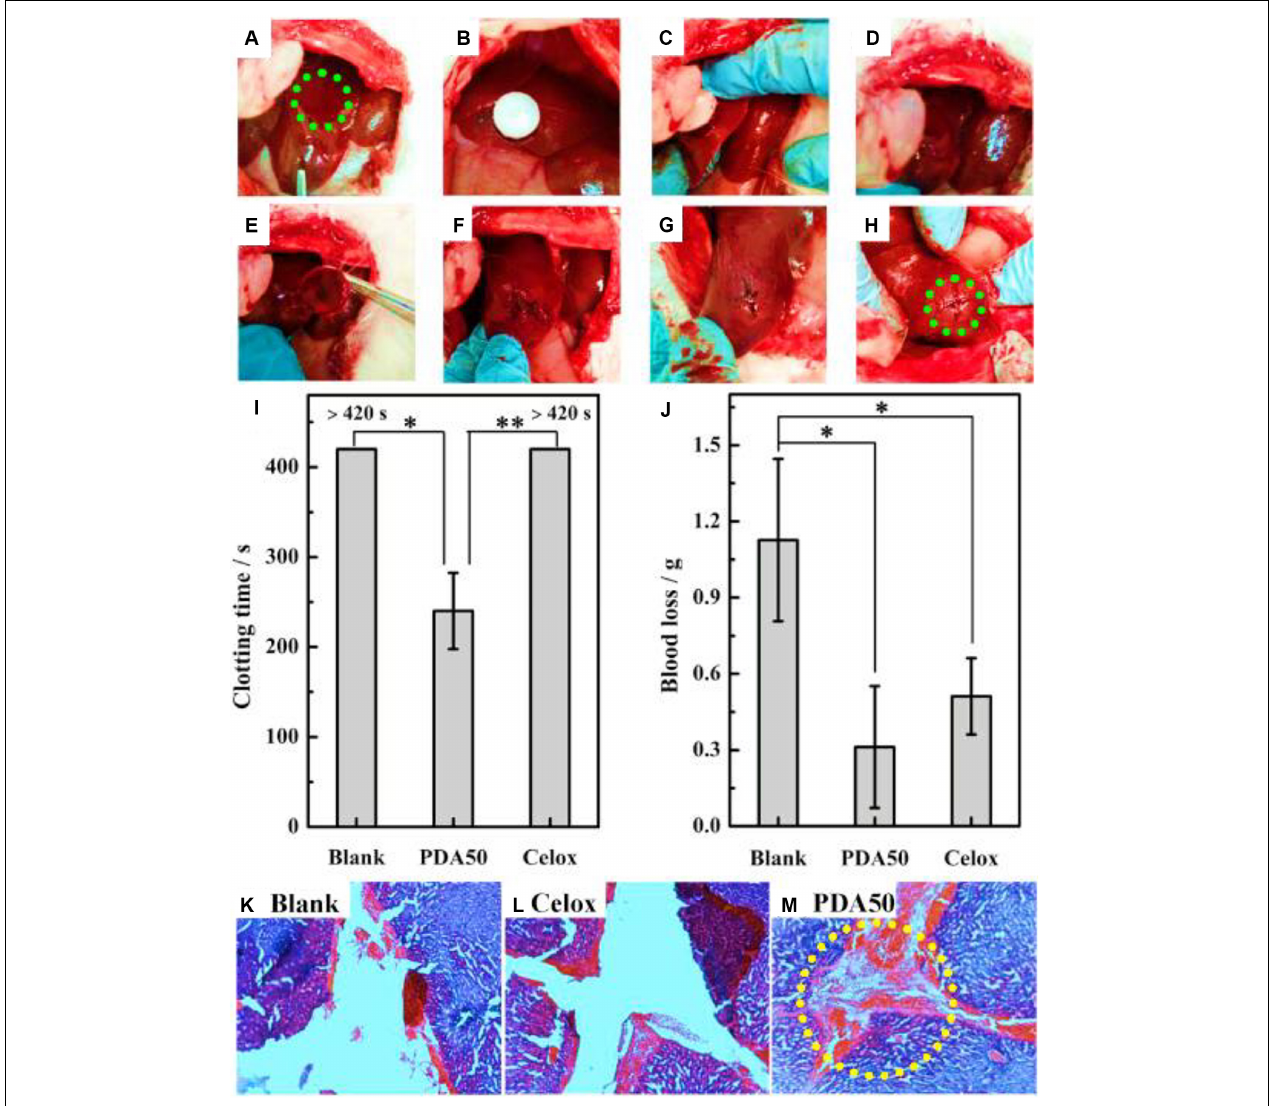
FIGURE 8 | Hemostasis of liver injury using the rabbit model. (A) Creation of liver injury in the left medial lobe. (B–D) Treatment with PDA sponge. (E–G) Hemostasis maintained after removal of sponge. (H) Hemostasis kept even squeezing the wound. (I,J) Coagulation time and blood loss of liver injury. (K–M) Histopathology of liver trauma. Reproduced from Liu et al. (2019) with permission from Copyright 2019